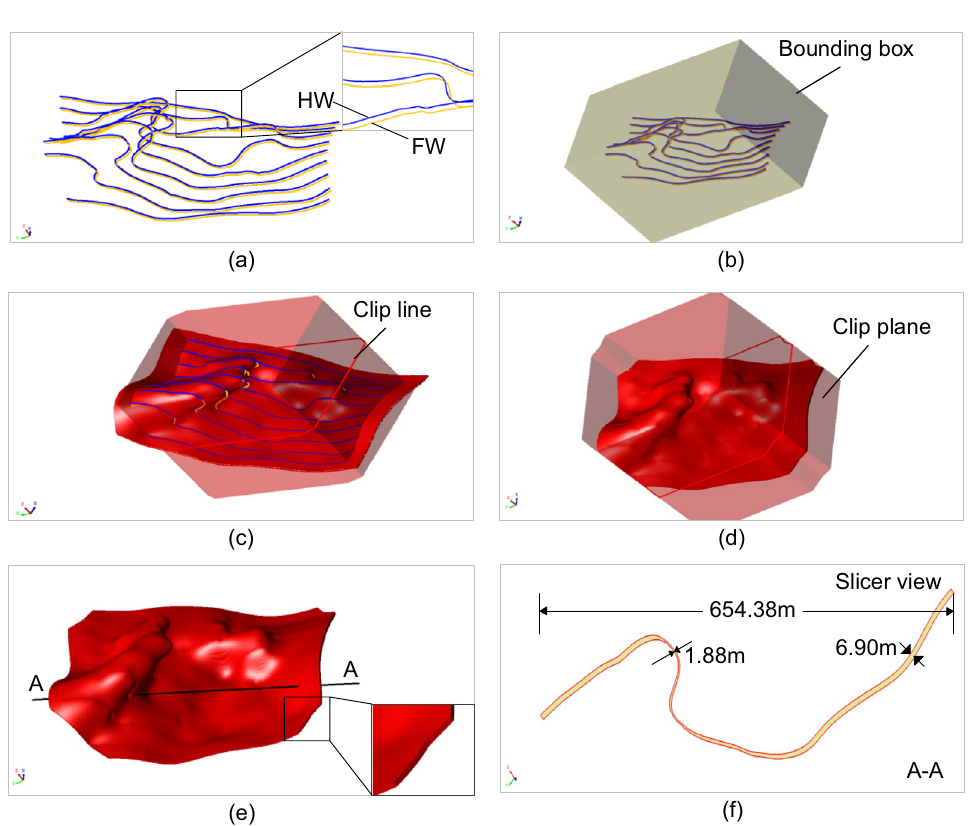
Figure 10. Implicit modeling of a narrow vein orebody model. ( a ) Contour polyline data; ( b ) rectangle bounding box; ( c ) initial model; ( d ) clipped model; ( e ) final model; ( f ) slicer